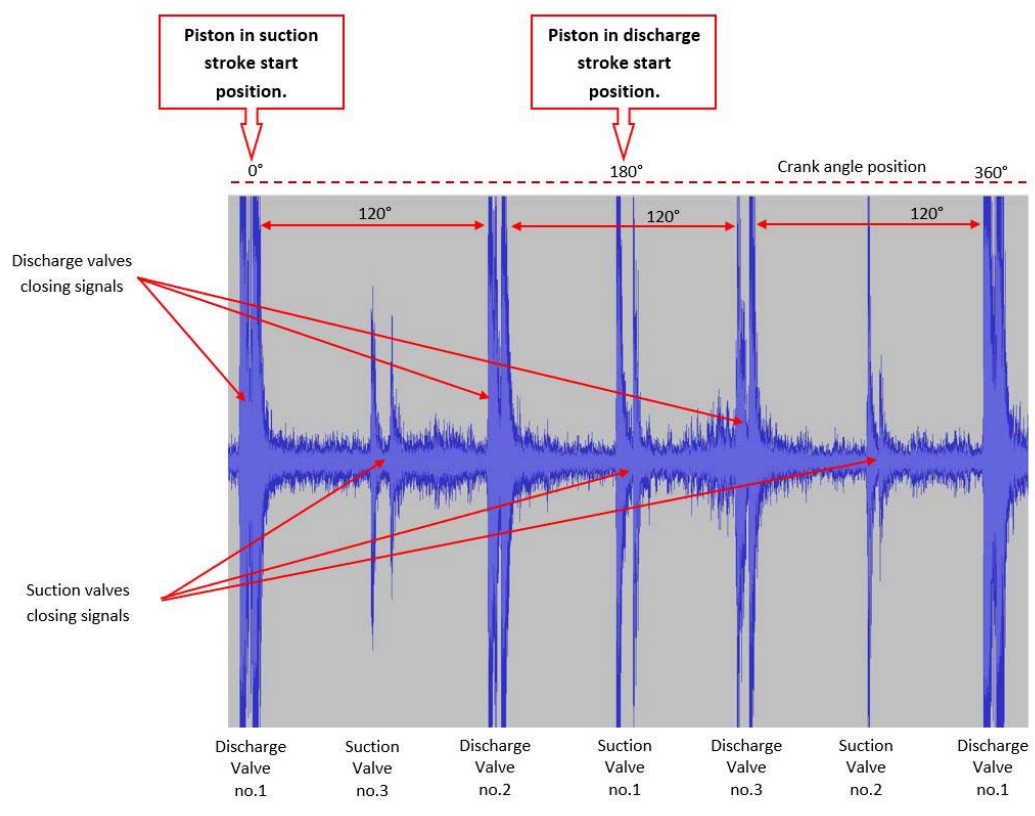
Figure 10. AE signal source from the running pump valves, with indicated stages of valve